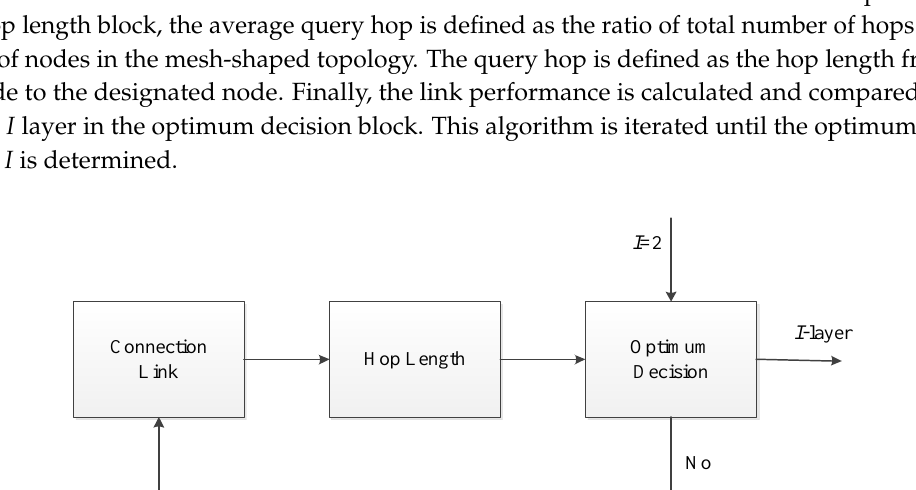
Figure 2. Average path length in a scatternet.